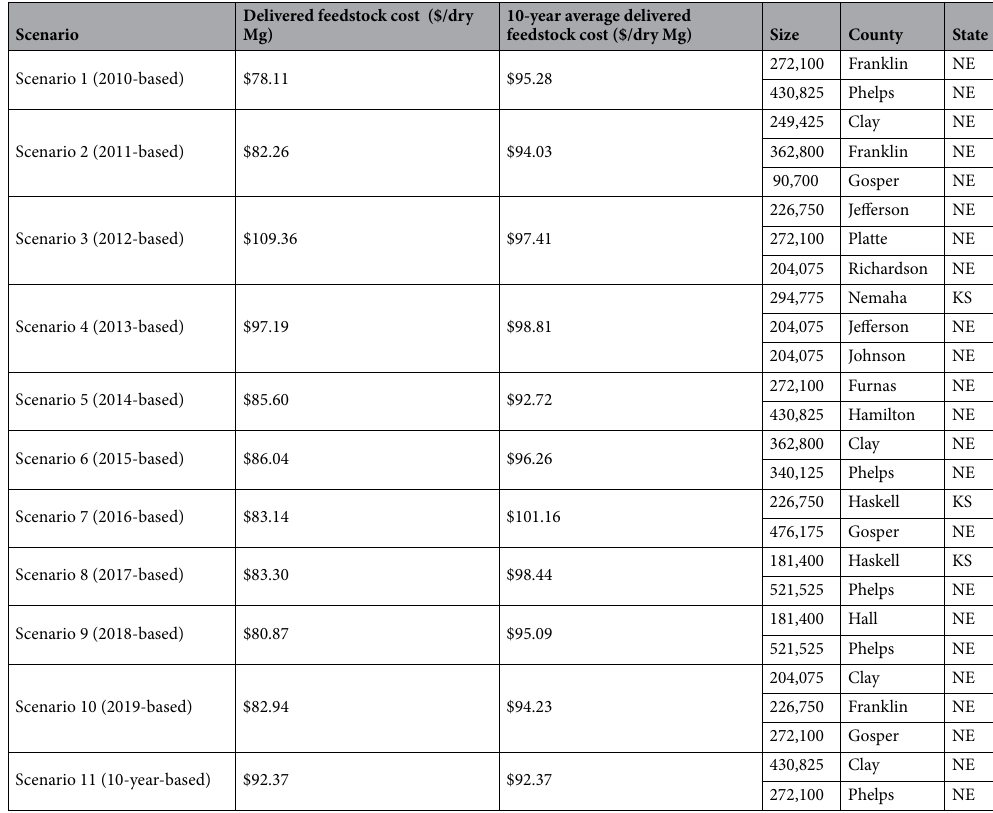
Table 1. Comparison of delivered feedstock cost, numbers of depot location and size if supply chain design decision is made based on single year vs 10 year temporal and spatial variability in biomass yield and quality.